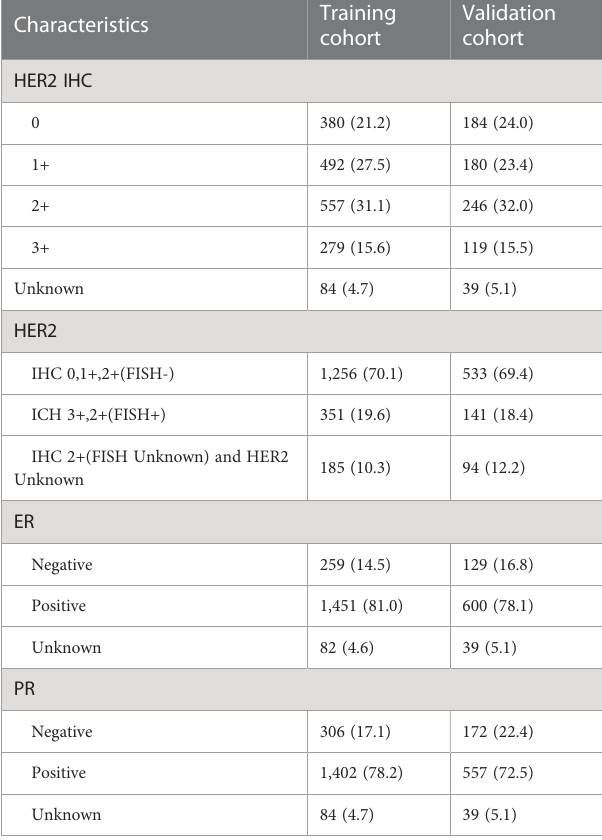
nomogram scales. An individual patient ’ s score (black dot) is placed on each variable axis. Red lines and dots are drawn upward to determine the points received by each variable; the sum (308) of these points is located on the total points axis, and a line is drawn downward to the NSLN axes to predict the risk of non-SLN metastasis, which for this patient is 36.1%.